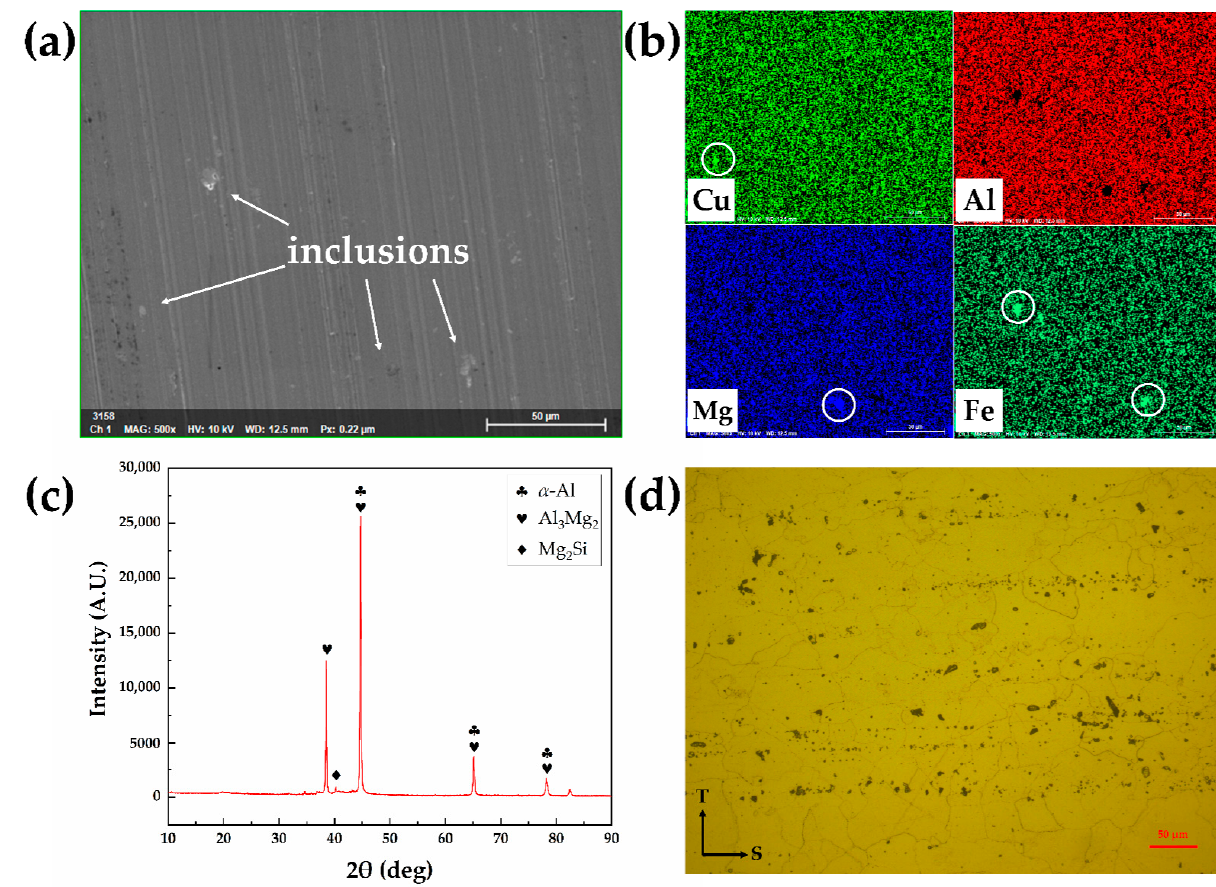
Figure 2. The SEM morphology ( a ), EDS spectral diagram ( b ), and XRD diffraction pattern ( c ) of the uncorroded specimen of the 7B04-T74 aluminum alloy, with the metallographic morphology ( d ) of the surface of the specimen after